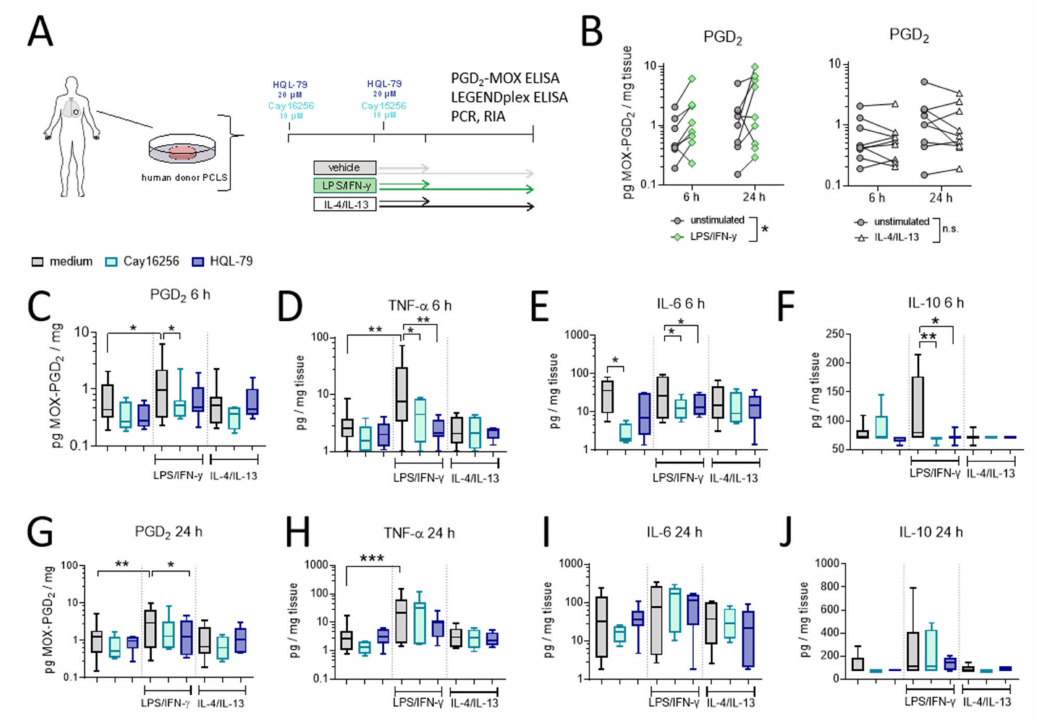
Figure 7. LPS/IFN- γ , but not IL-4/IL-13, induce hPGDS-dependent PGD 2 release and cytokine secretion by human